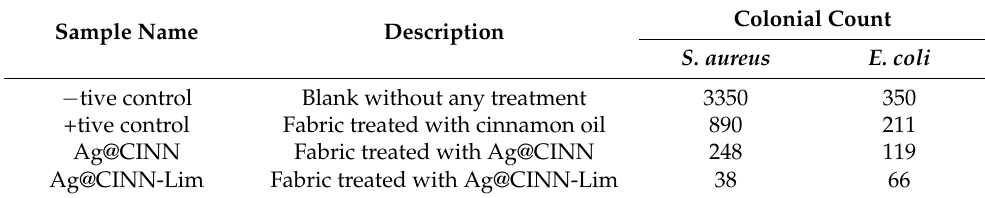
Table 1. Sample descriptions used for antimicrobial testing with respective colonial growth.